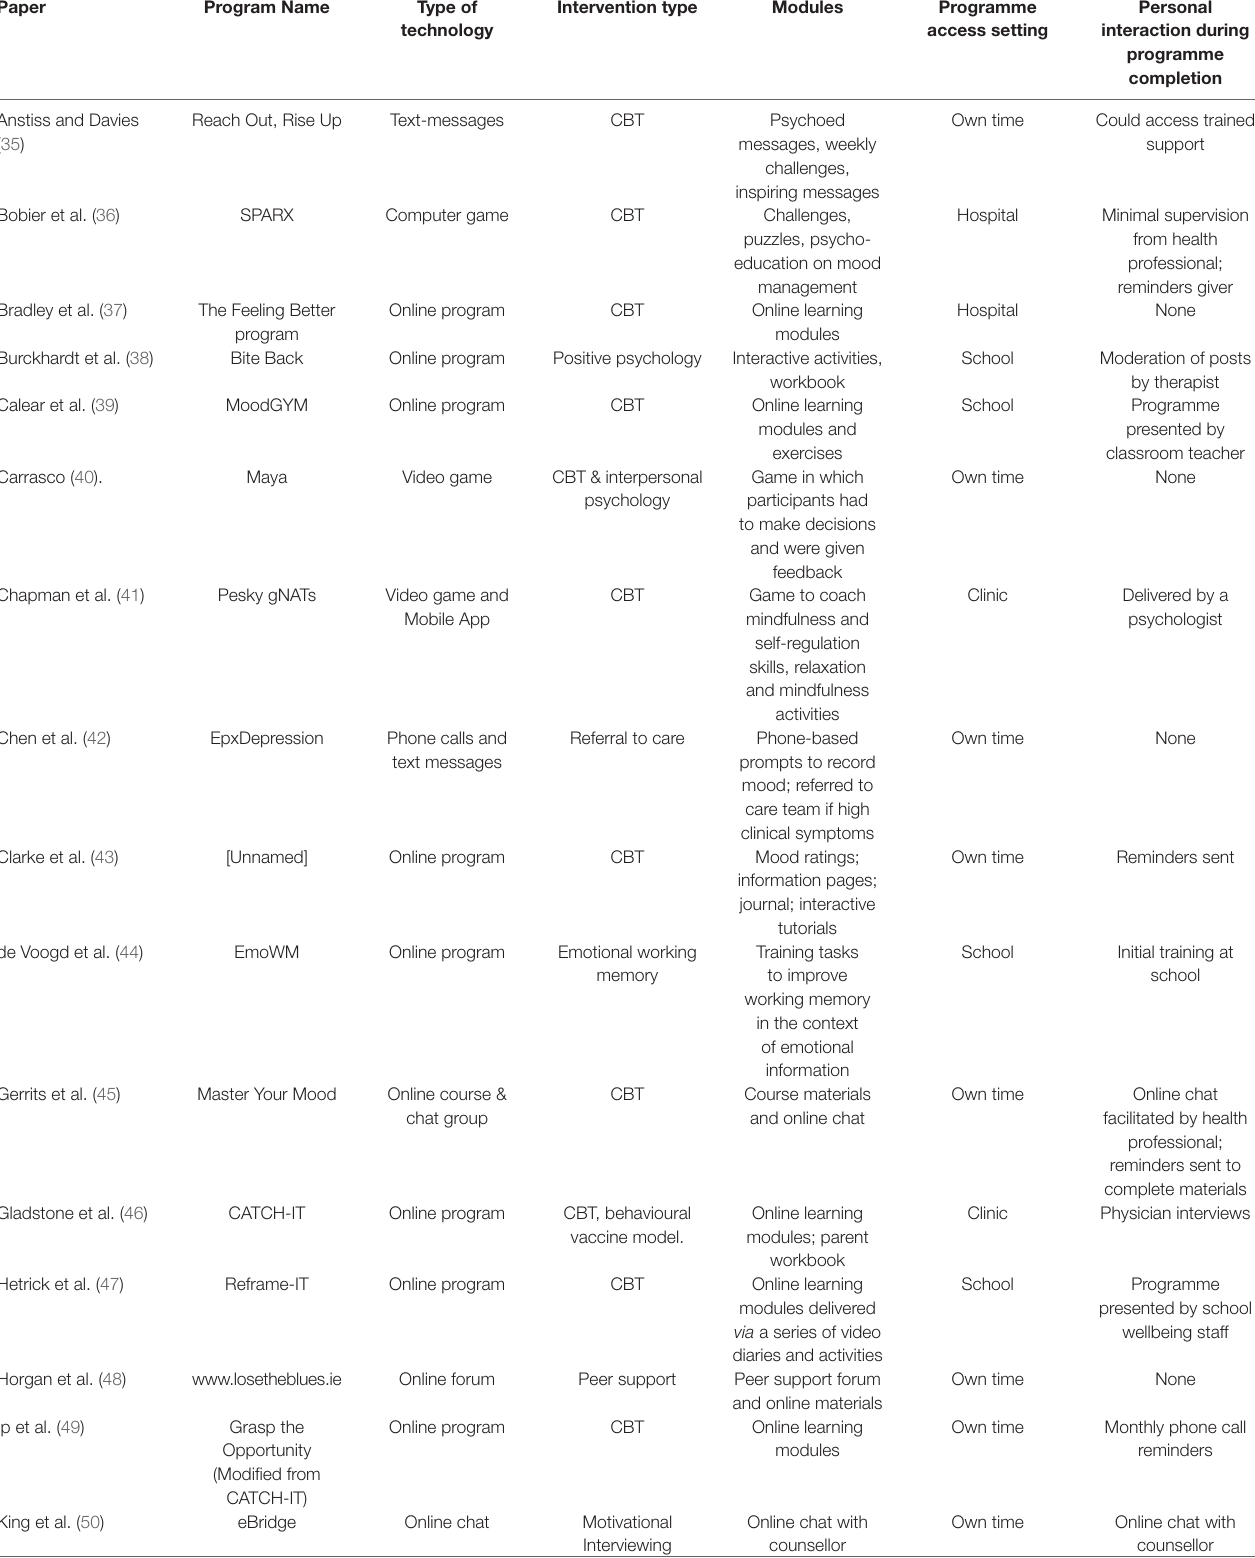
TABLE 2 | Intervention